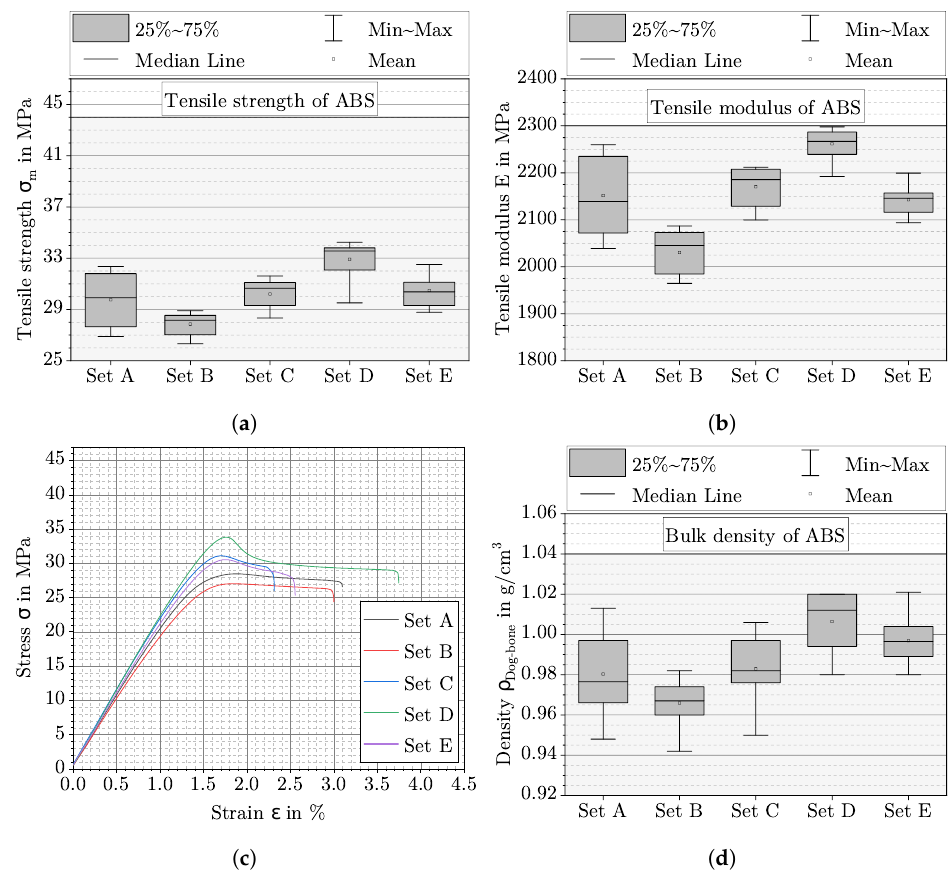
Figure 7. Mechanical properties and density of the dog-bone specimens with the specific parameter sets from Table 2. Set A = LT150DAR14DR32, Set B = LT200DAR11DR45, Set C = LT200DAR14DR75, Set D = LT200DAR17DR113, and Set E = LT250DAR14DR147. ( a ): Tensile strength, ( b ): tensile modulus, ( c ): one representative stress–strain curve for each parameter set, and ( d ): density for the specific parameter